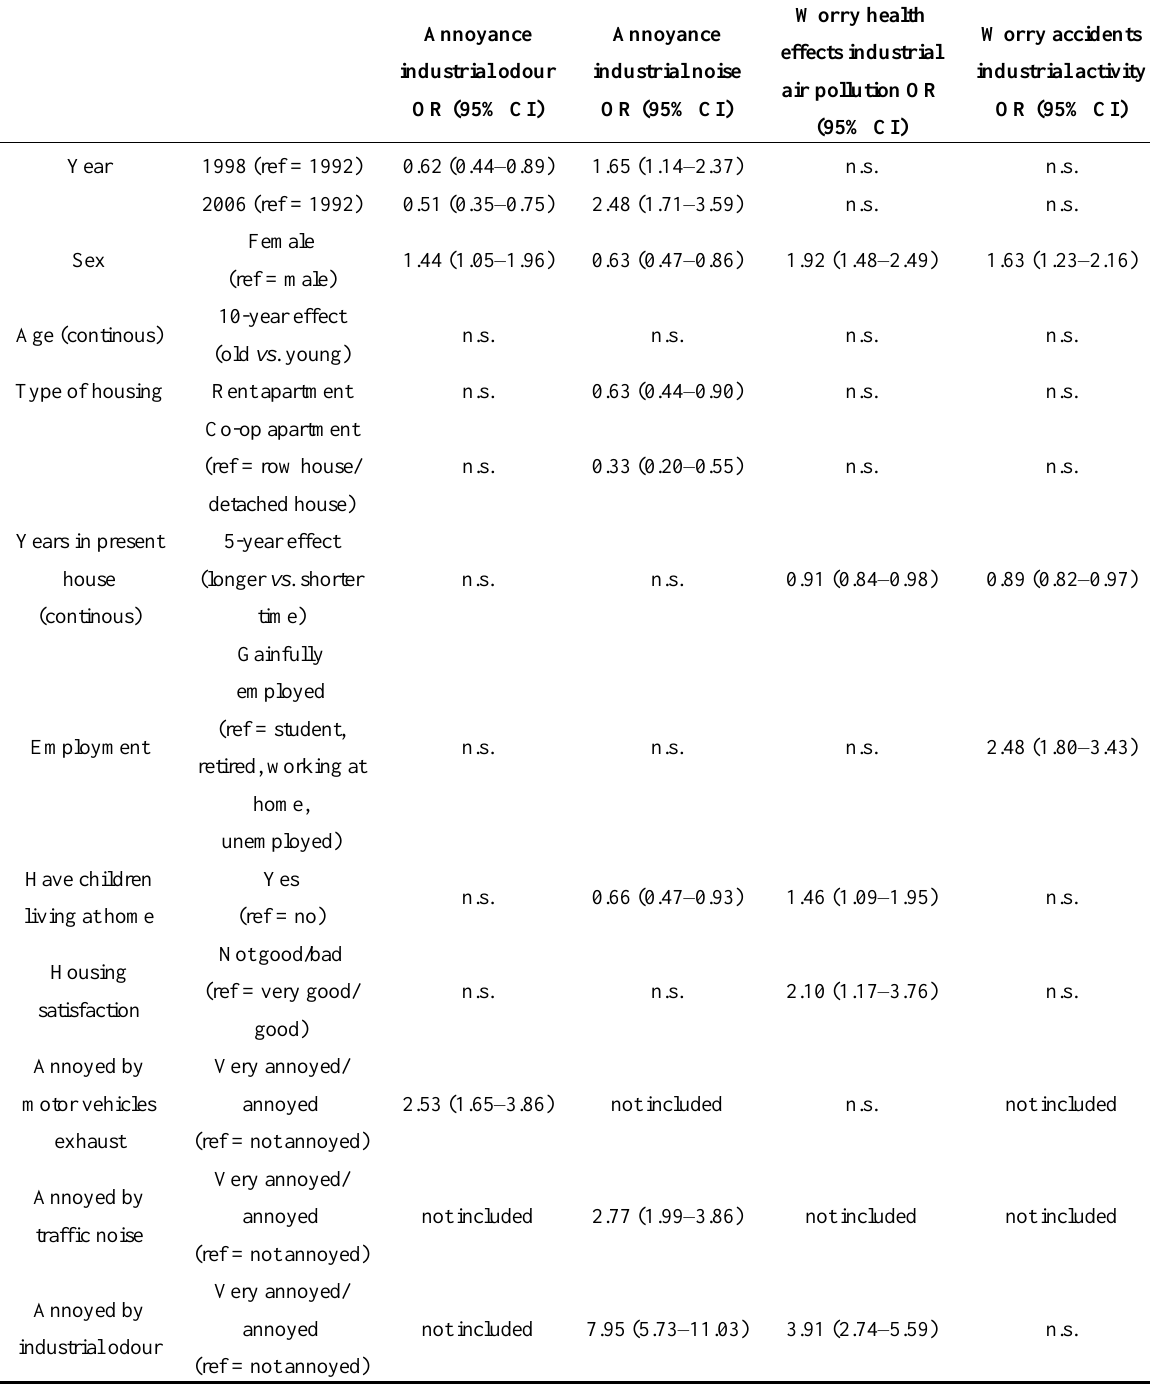
Table 3. Odds ratios (OR) for the variables associated with each outcome in the exposed area (Model